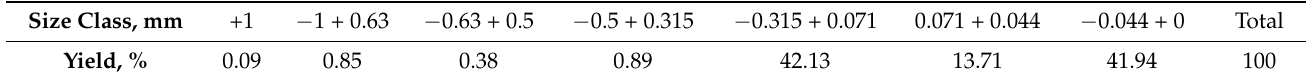
Table 1. Sieve analysis of the sample of old enrichment tailings.